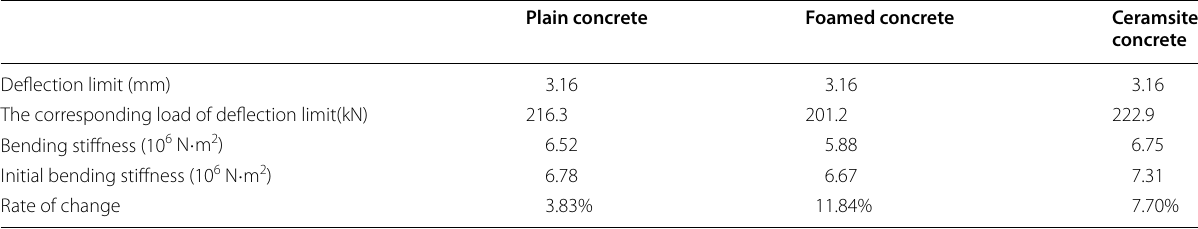
The initial bending stiffness represents the bending stiffness of 50kN.